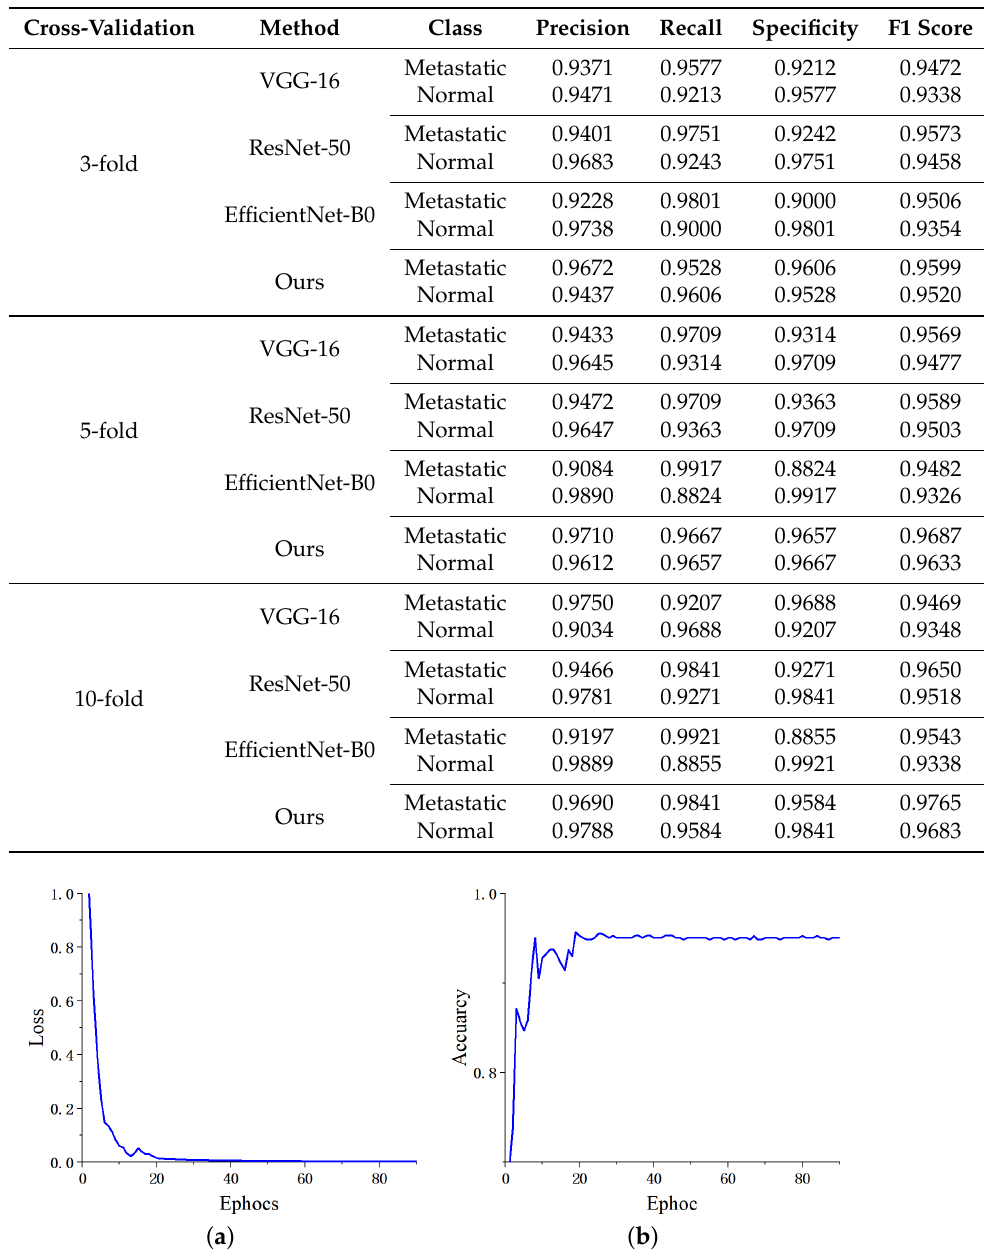
Table 10. Classification performance of the proposed method on dataset BT-2C.